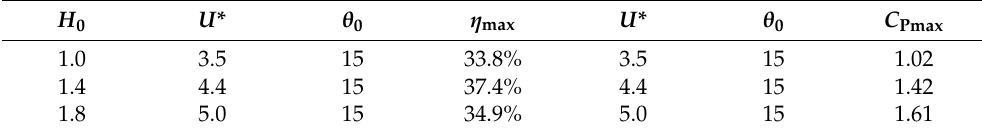
Table 2. Deviations of maximum lift coefficient for different mesh and time step